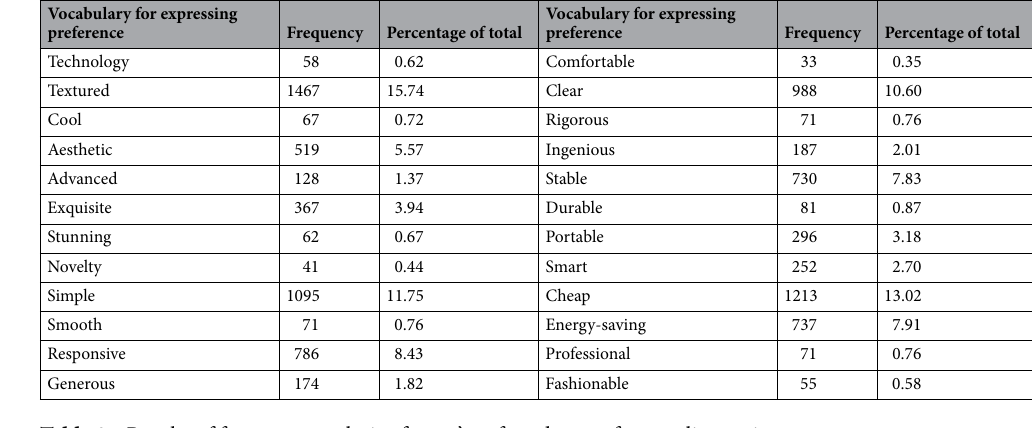
Table 3. Results of frequency analysis of users’ preferred terms from online reviews.